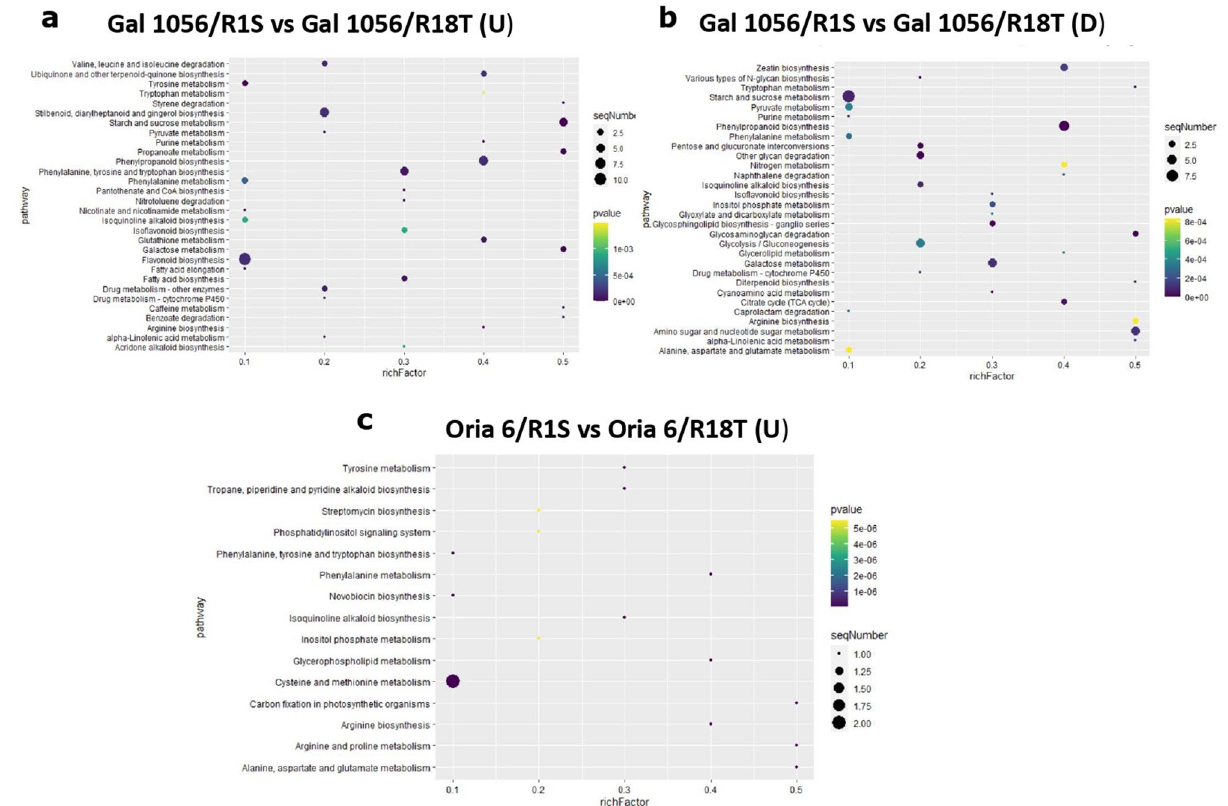
Figure 3. Top 30 enriched KEGG pathways analysis of ( a ) significantly upregulated (≥ 1.5 Log2FC) and ( b ) downregulated (≤ − 1.5 Log2FC) genes exclusively differentially expressed in Gal 1056/R1S versus Gal 1056/ R18T. ( c ) Upregulated (≥ 1.5 Log2FC) genes exclusively differentially expressed in Oria 6/R1S versus Oria 6/ R18T. Rich factor represents the ratio of the DEG number and the number of all genes in the pathway. P values ( P < 0.05) were calculated according to the Wald